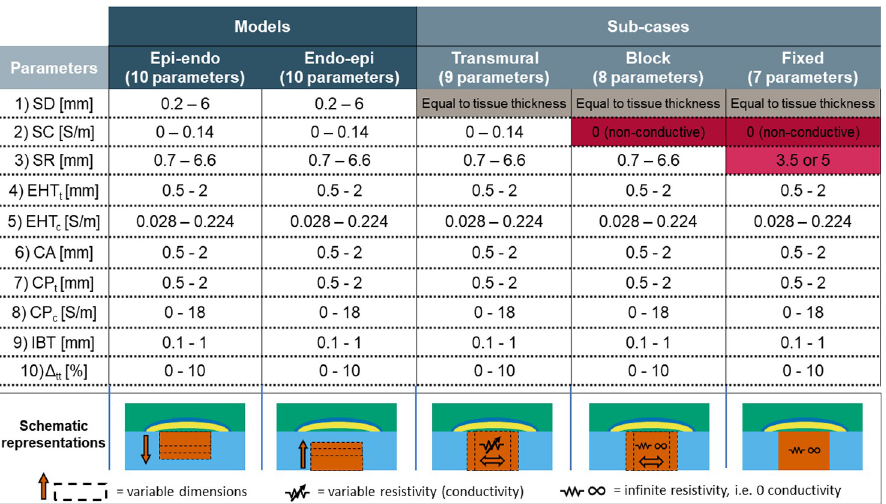
Fig 2. Value ranges of the 10 parameters (rows) used in the two versions of our model (Epi-endo, and Endo-epi, 1 st and 2 nd columns respectively). The 3 sub-cases (Transmural, Block and Fixed) are shown in the 3 rd , 4 th and 5 th columns. The table shows which parameters of the original model are fixed in order to derive each sub-case. The bottom row displays representations of each model version and subcases.